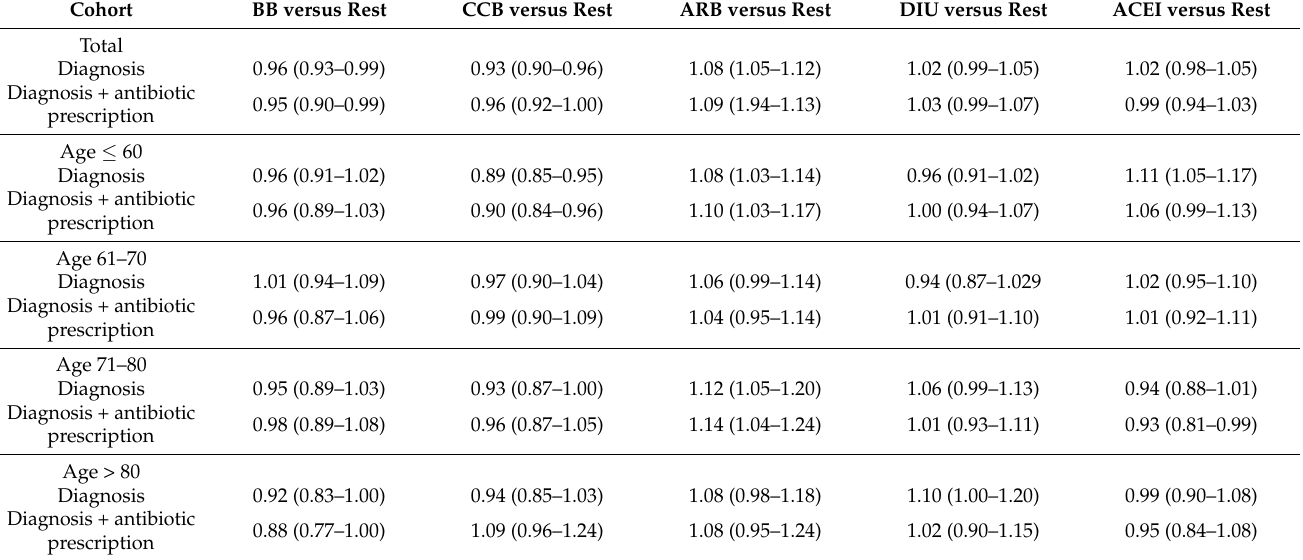
Table 2. Association between antihypertensive therapy (as compared to other antihypertensive therapy classes) and the incidence of pneumonia and acute bronchitis in patients followed in general practices in Germany (Cox regression